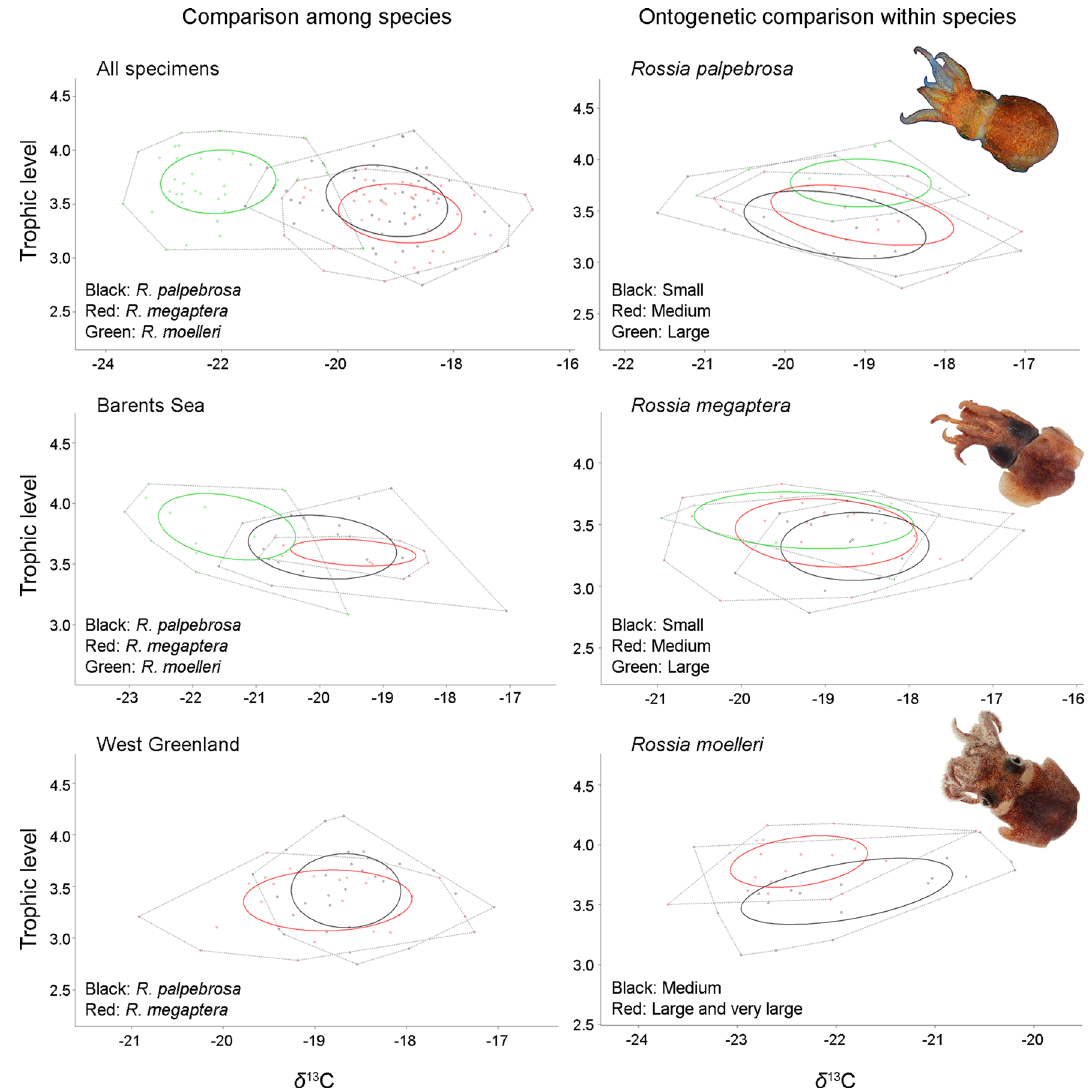
Figure 1. Isotopic niches of the studied species of the genus Rossia : comparison among species and ontogenetic comparison within species. Photo credits: Olga L. Zimina ( R. moelleri